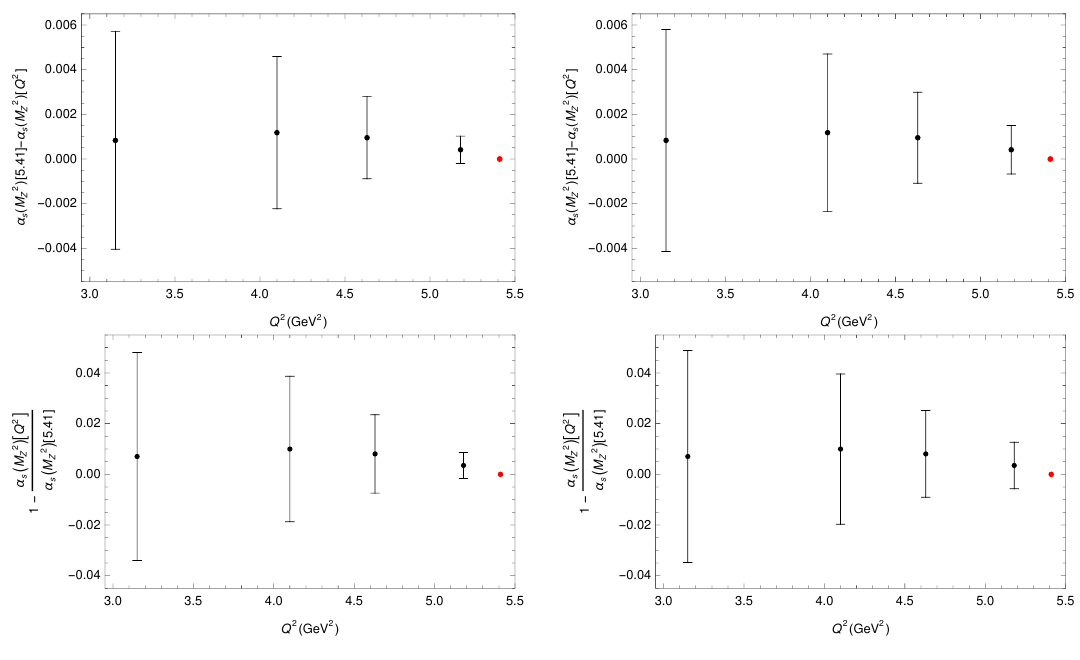
Table 14 . Averaged results for α ( n f =5) s ( M 2 variations and O 6 are assumed to be uncorrelated.